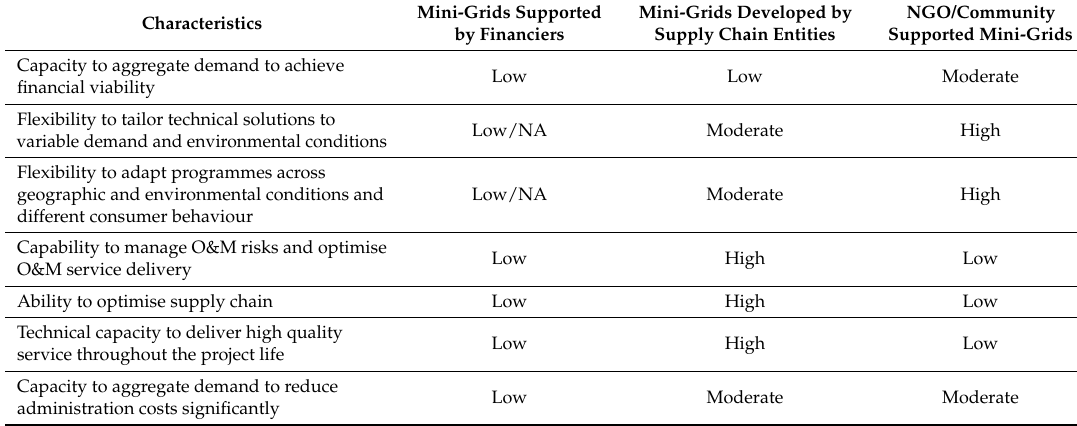
Table 4. Comparative position of characteristics affecting technical capability. Source: